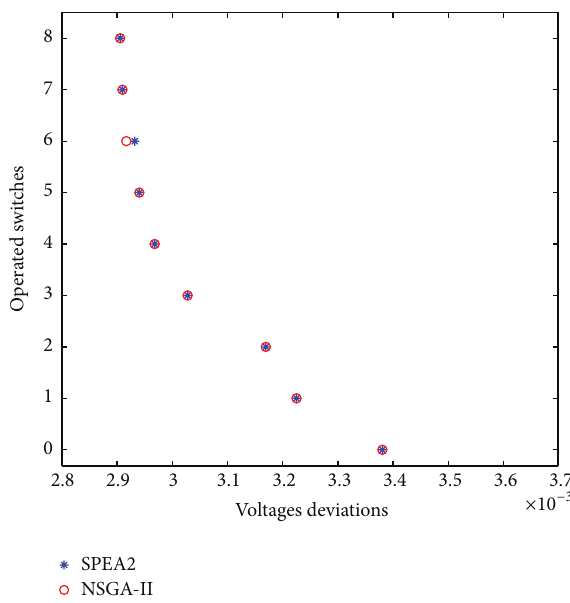
Figure 10: Approximate Pareto-optimal solutions to the problem of optimizing voltage deviations 𝑓 2 and the number of operated switches 𝑓 3 .